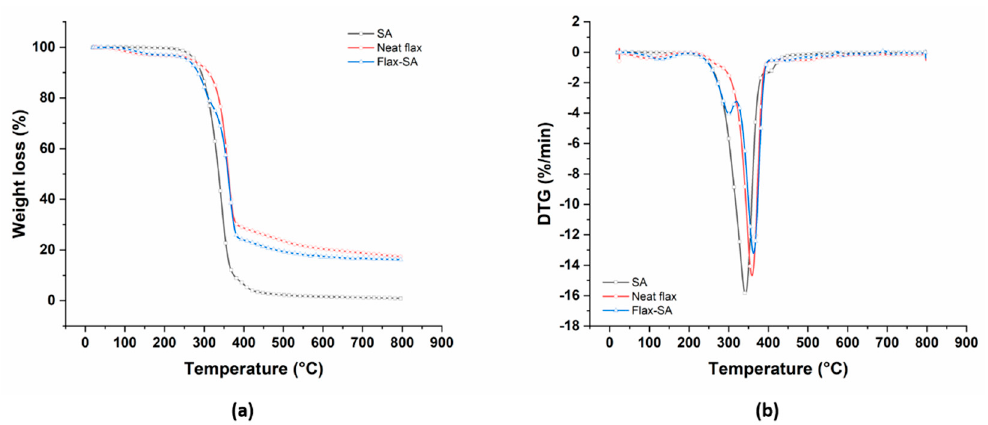
Figure 15. ( a ) Thermal stability (TGA) thermograms and ( b ) derivative thermogravimetry (DTG) curves of flax fabrics before and after the treatment with stearic acid (SA).